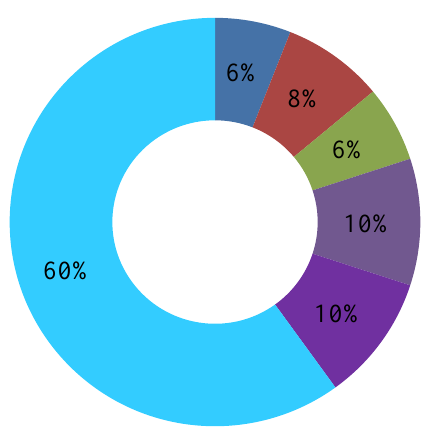
Figure 6. Random Way point